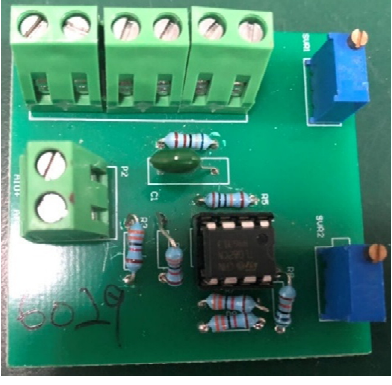
Figure 12. The pH Figure 12. The pH module.